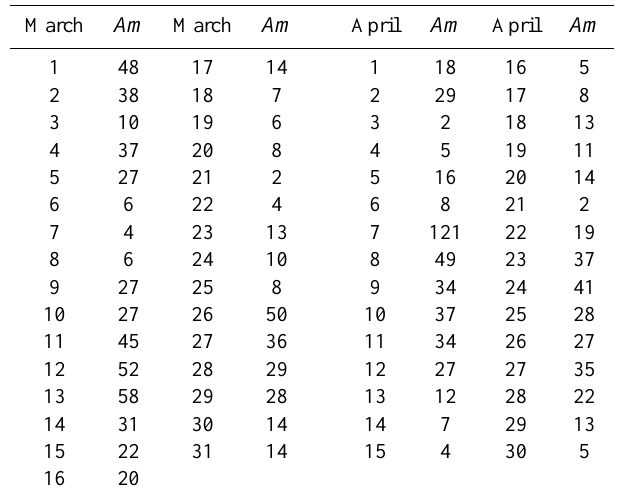
Fig. 1. ESF occurrence at Korhogo from December 1994 to